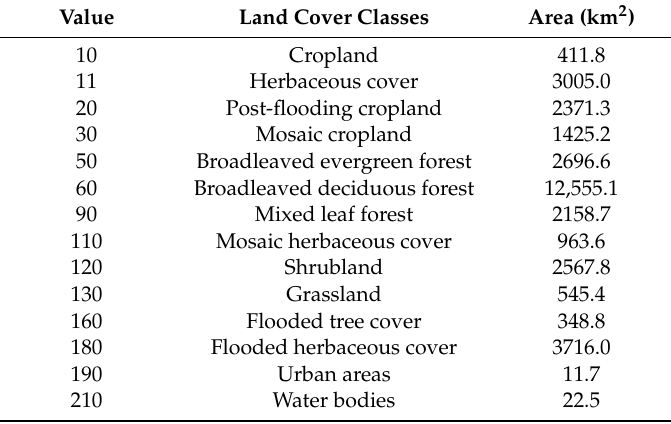
Table 3. The land cover classes of the Kilombero Valley (KV) river basin based on the 300 m spatial resolution global land cover map for the year 2015 provided by the European Space Agency (ESA) Climate Change Initiative